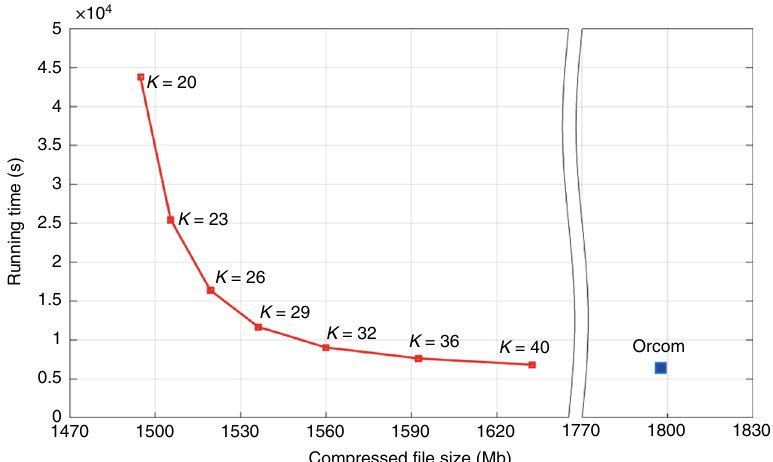
Fig. 3 The tradeoff between the running time and compression performance of Assembltrie. The tradeoff between Assembltrie ’ s running time and compression rate as a function of the user set parameter K (initial match length) on the data set ERR174310. The blue point depicts the performance of Orcom on the same data set with default